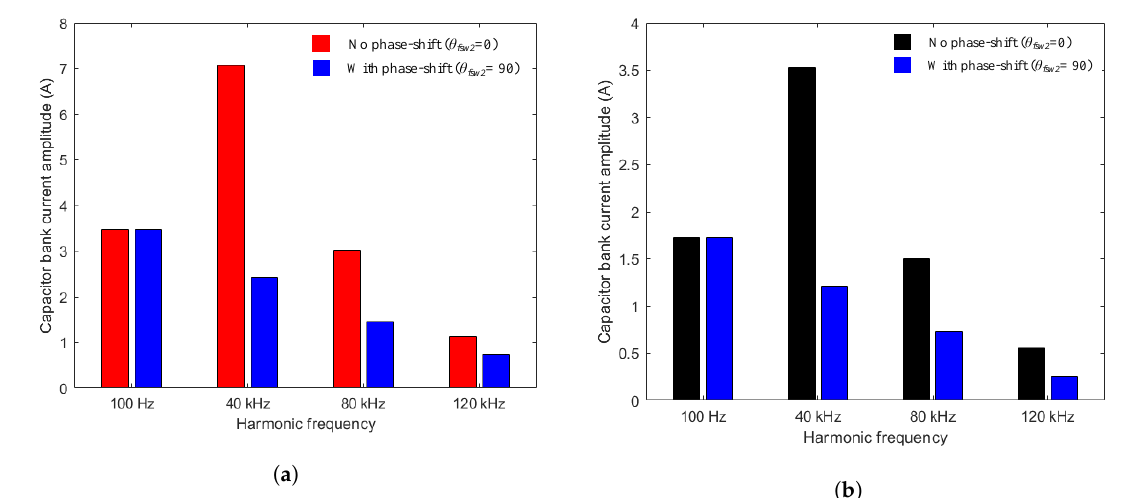
Figure 12. Effect of the optimal shift in the DC-capacitor bank current harmonics for: ( a ) the multi-converter system with a common DC-bank, ( b ) the multi-converter system with individual DC-banks.